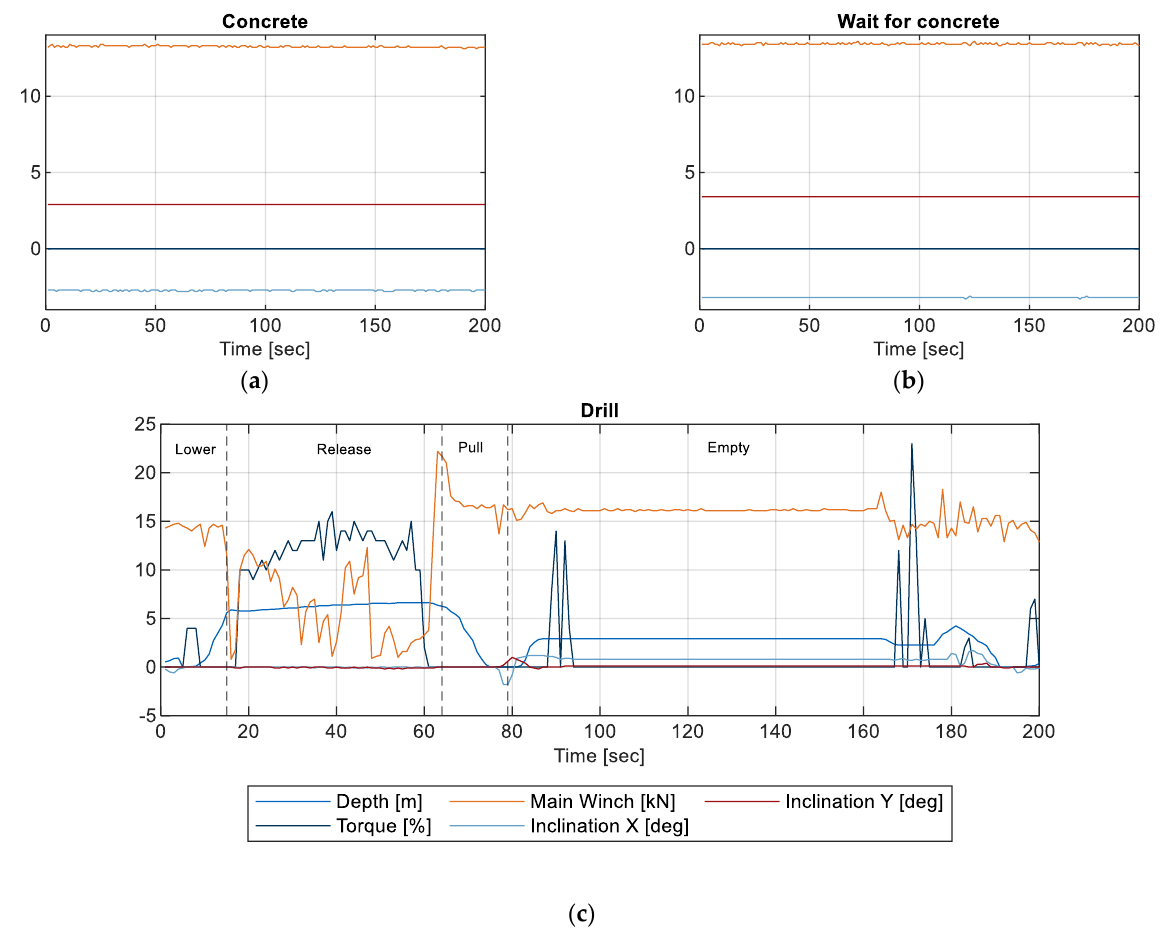
Figure 9. Raw data from the Kelly drill rig for different activities: ( a ) concrete; ( b ) pause; and ( c ) drill.